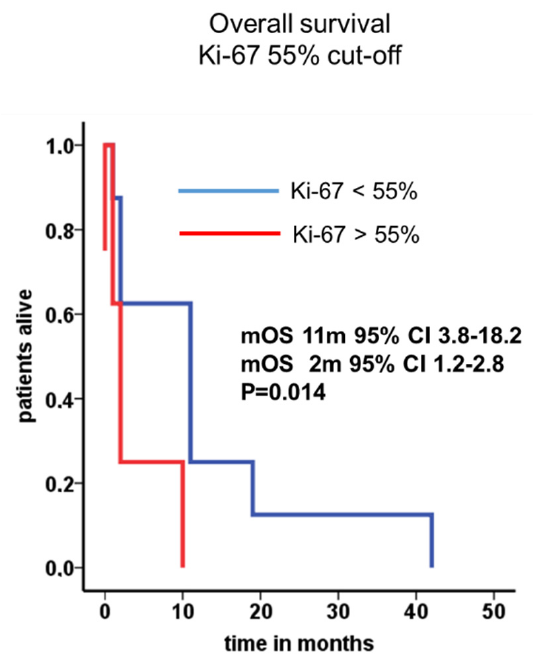
Figure 2. Median overall survival in patients with LC and NEC stratified by Ki-67. Median overall survival in patients with Ki-67 <55% (11 months, blue line) or higher than 55% (2 months, red line) were depicted.